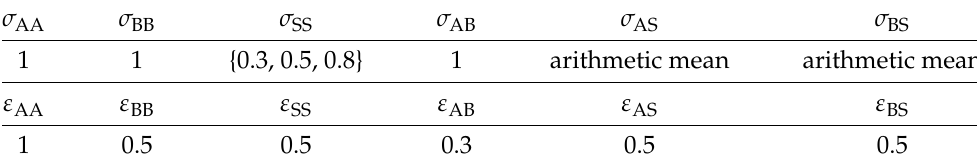
Table 1. The interaction parameters employed in the present bead-spring copolymer